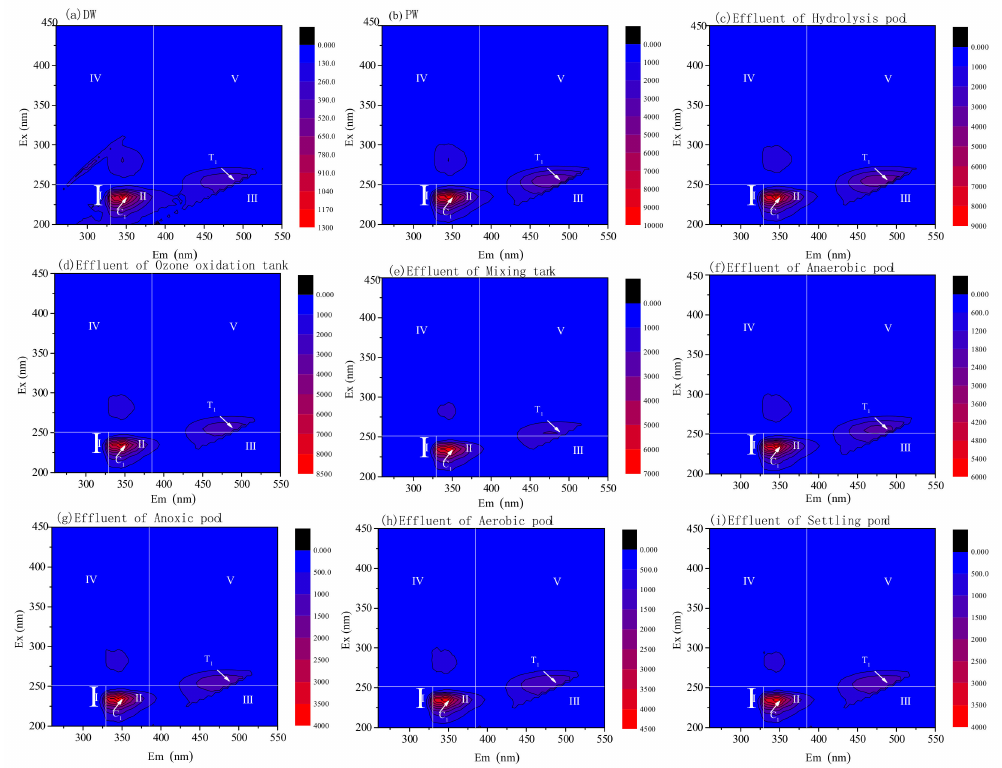
Figure 6. The excitation–emission matrix (EEM) spectra of each process e ffl uent for pre-ozone (50% PW). (( a ) DW sample; ( b ) PW sample; ( c ) E ffl uent of Hydrolysis pool sample; ( d ) E ffl uent of Ozone oxidation tank sample; ( e ) E ffl uent of Mixing tank sample; ( f ) E ffl uent of Anaerobic pool sample; ( g ) E ffl uent of Anoxic pool sample; ( h ) E ffl uent of Aerobic pool sample; ( i ) E ffl uent of Settling pool